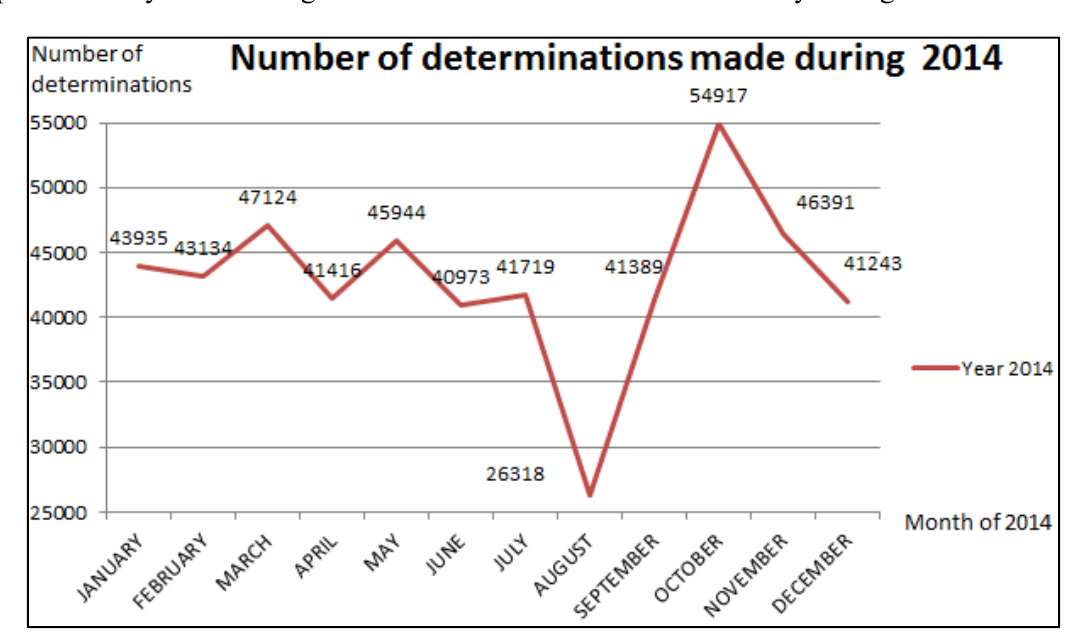
Figure 2. Measurements performed during 2014. The vertical axis represents the number of measurements performed in the modules system of chemoluminiscence and the horizontal axis represents the